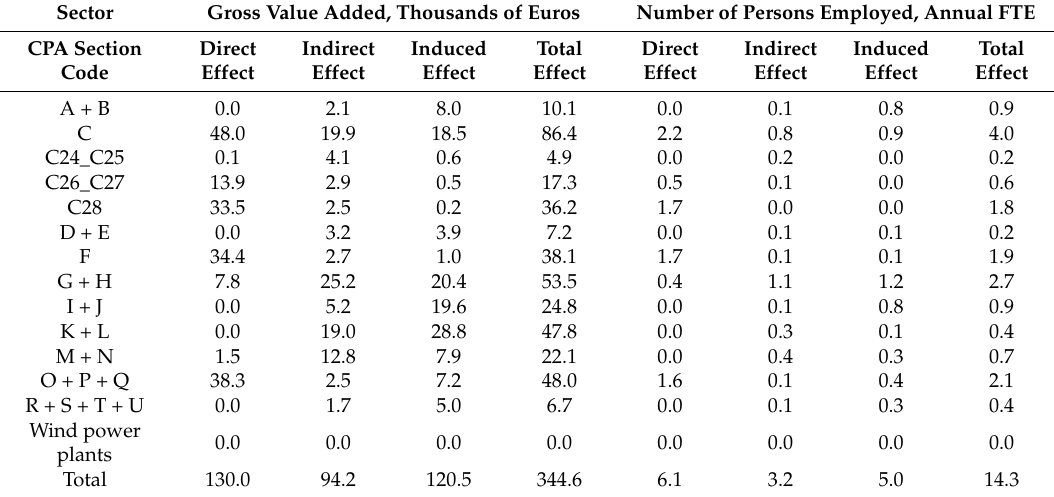
Table 6. Investments channel, total effects of investments valued 1 million